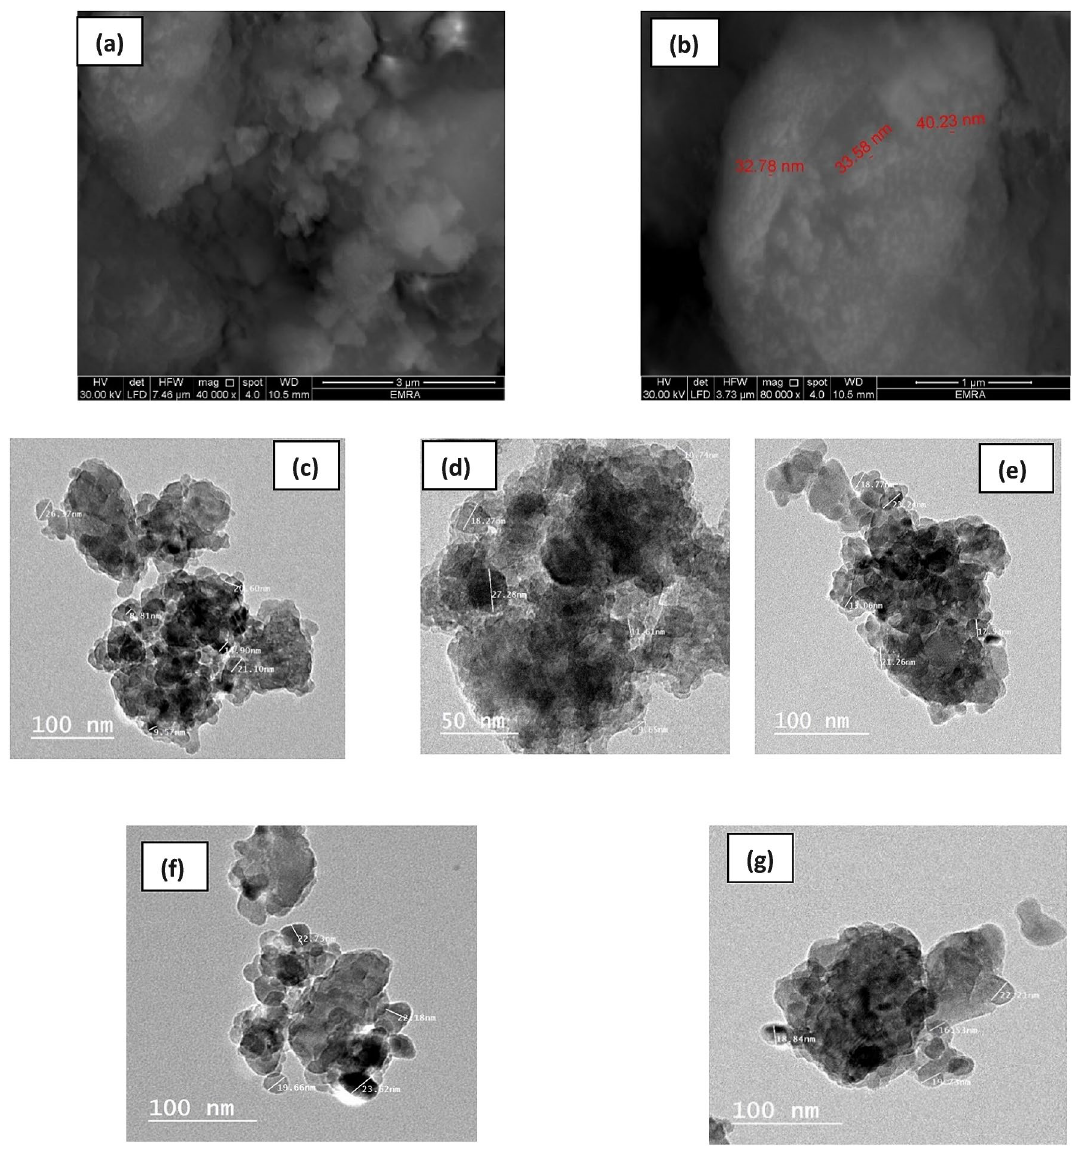
Fig. 3 Micrographs and size of pure eggshell nanoparticles structure before adsorption of Pb (II) using SEM ( a , b ) and TEM ( c – g ),